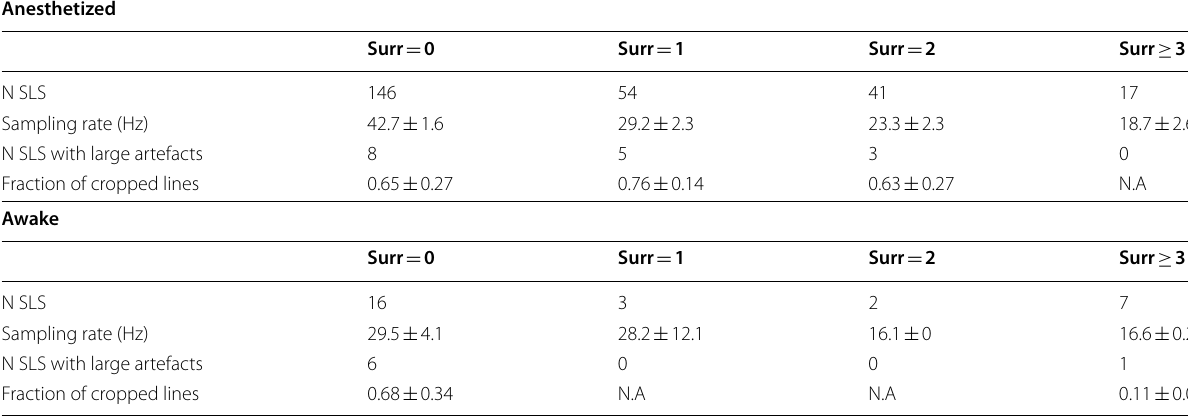
SEM ± Surr 0 Surr 1 Surr = =